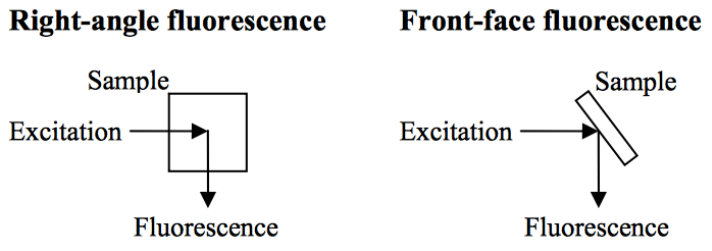
Figure 5. Principles of right-angle fluorescence and front-face